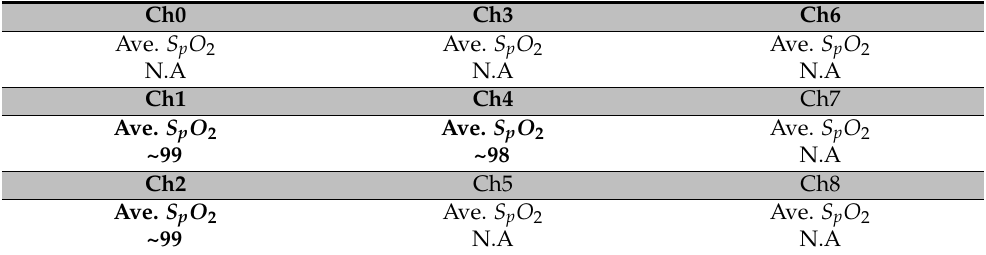
Table 6. The calculated blood oxygen concentration of the array sensors using the design with a sensor spacing of 5 mm.